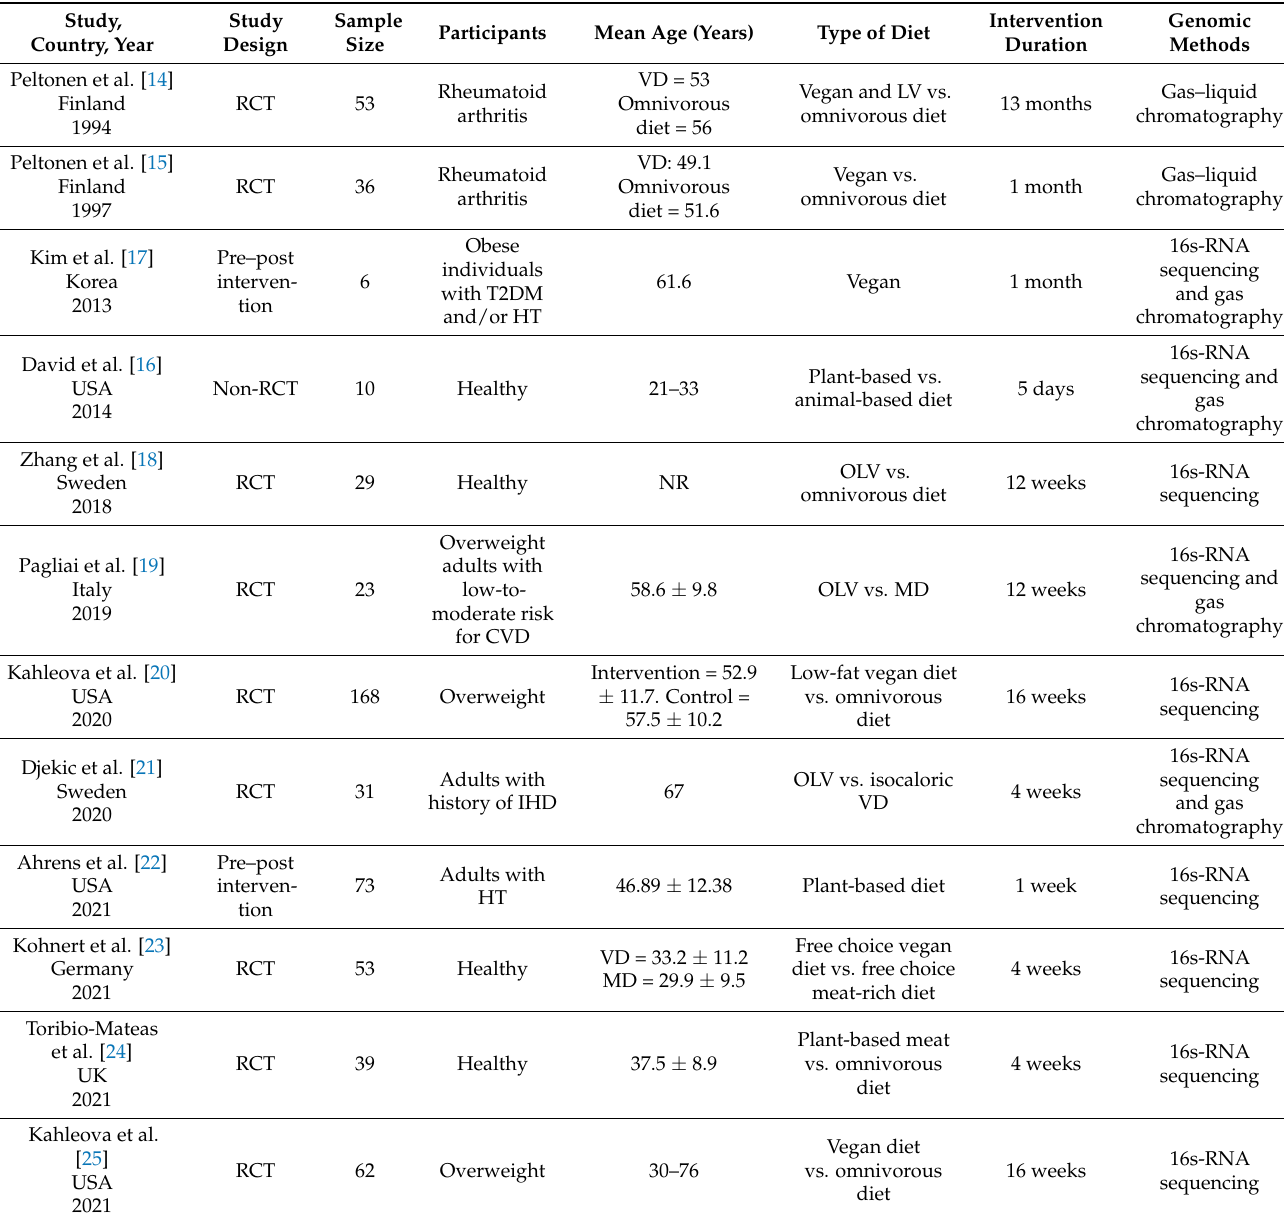
Table 1. Summary characteristics of included studies (n =